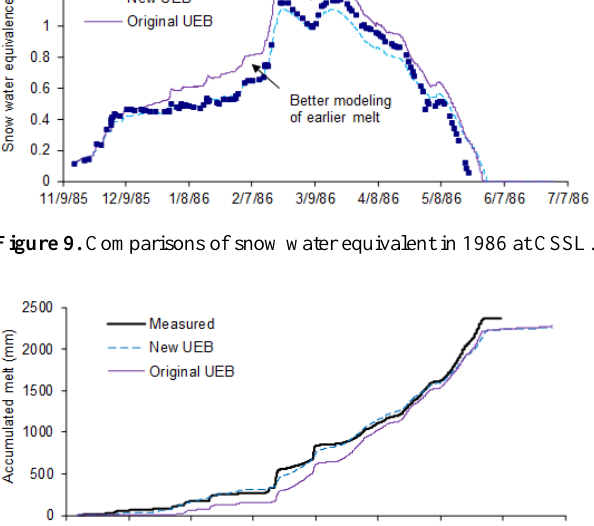
results fit the measurements well. The discussion section fur- ther examines these results.